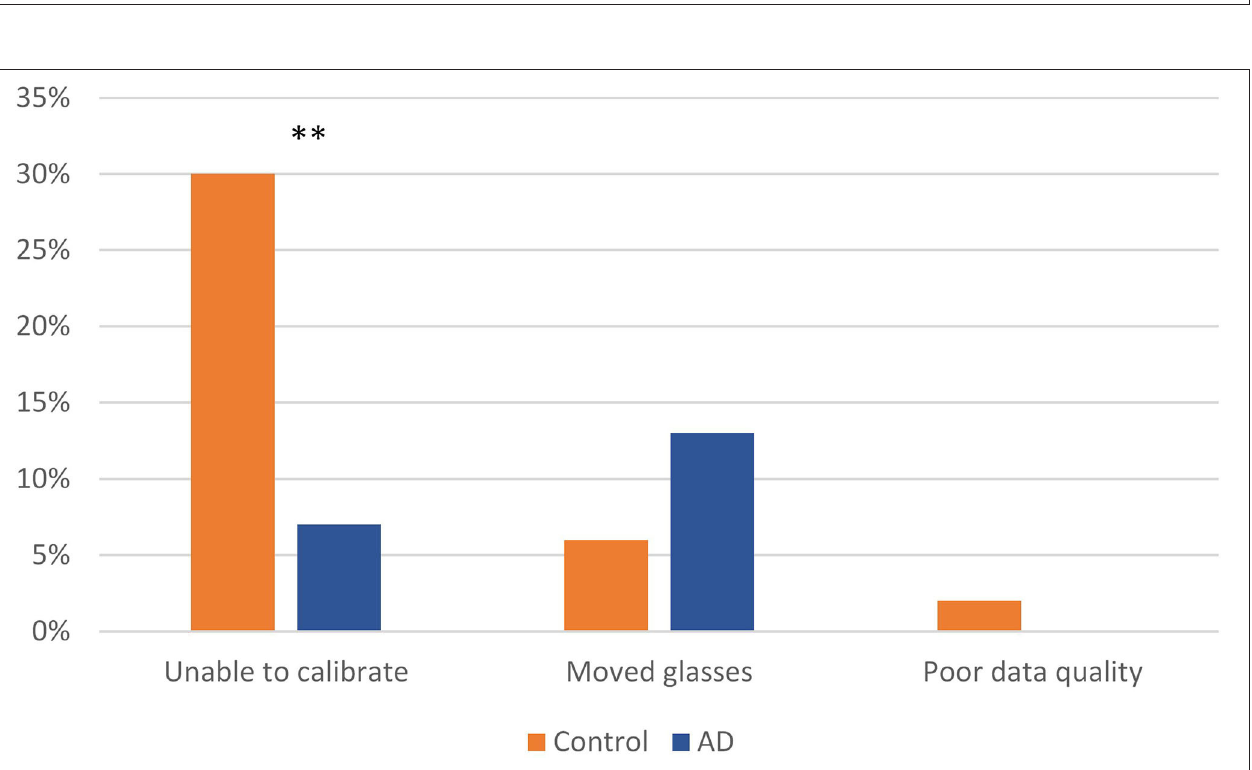
FIGURE 3 | Feasibility measures: eye tracking. ** p <